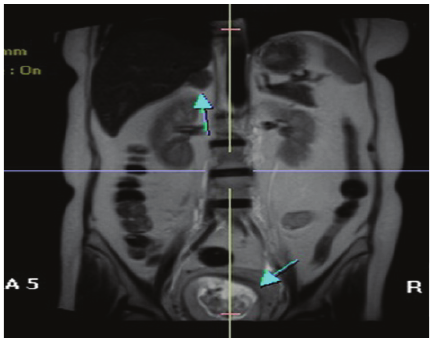
Figure 1: MR image of the adrenal adenoma and intrauterine fetus.